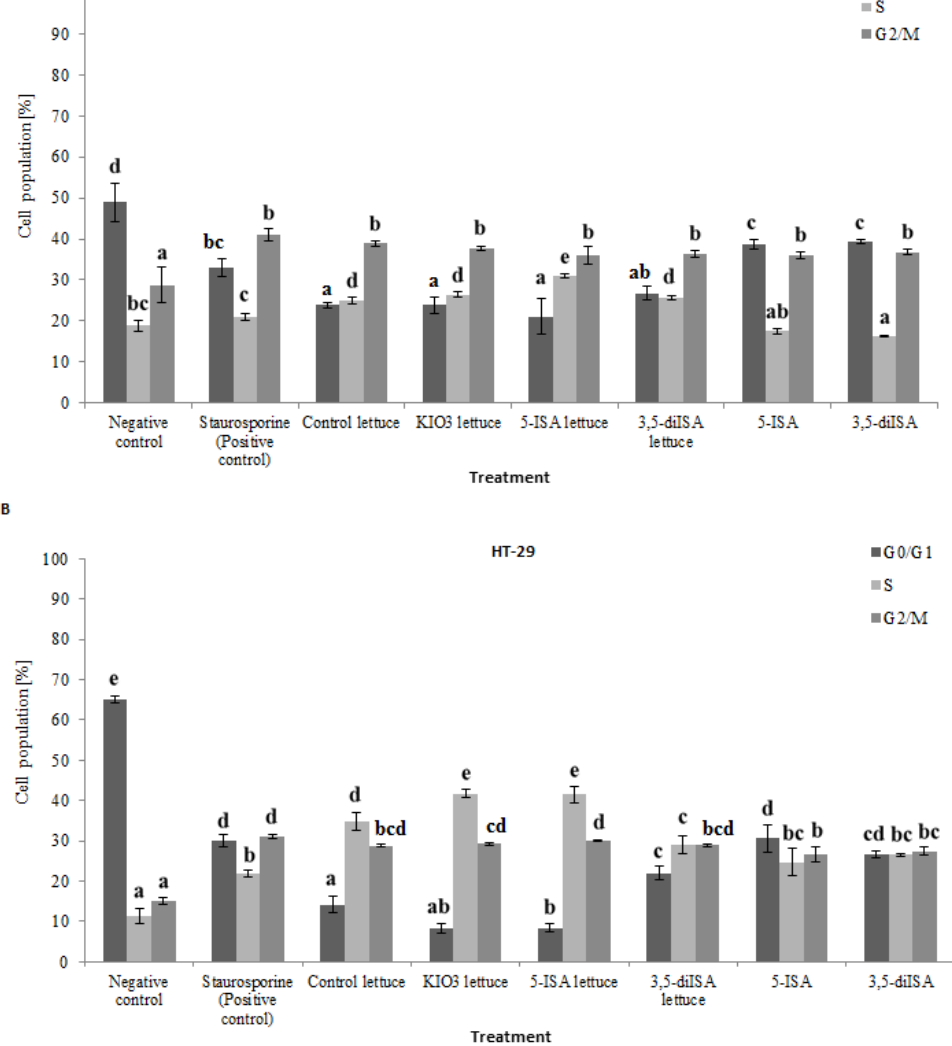
Figure 2. The effect of extracts from iodine-biofortified lettuce on cell cycle in human gastrointestinal cell line AGS ( A ) and colorectal adenocarcinoma cell line HT-29; ( B ). Cells were treated for 24 h with 1000 µ g/mL extracts from control lettuce, or KIO3- fortified lettuce, or 5-ISA-fortified lettuce, or 3,5-diISA-fortified lettuce, or synthetic 5-ISA, or synthetic 3,5-diISA, or 1.5 µ M staurosporine as positive control. Statistical significance was assessed using one-way ANOVA followed by Tukey’s post hoc. Columns with the same letter are not significantly different ( p >